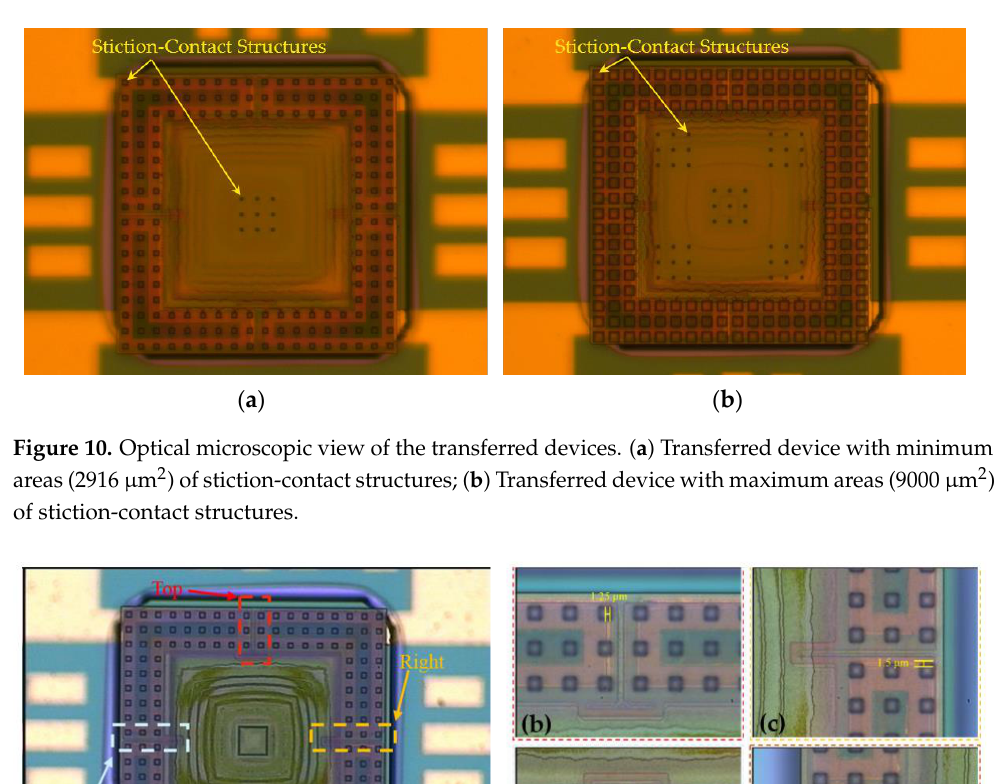
Figure 12. SEM view of the broken area of the temporary support structures of the tactile sensor. ( a ) SEM view of transferred device; ( b – e ) enlarged SEM views of the broken area shown in Figure 13a. As Figures 11a and 12a show, the size of the transferred tactile sensor is 180 μm  180 μm  1.2 μm, and the force area of the tactile sensor is only 120 μm  120 μm  1.2 μm. Moreover, the force application accuracy is extremely high because the designed full-scale force of the designed tactile sensor is only approximately 0.5 mN, and there is no suitable instrument to measure the sensitivity of the transferred tactile sensor directly. Therefore, different masses of the beam-shaped copper wire weights with a diameter of 85 μm are made to measure the sensitivity of the transferred tactile sensor, and the measurement principle of the beam-shaped copper wire weight is shown in Figure 13. As Figure 13 shows, one end of the beam-shaped copper wire weight is placed on the sensitive mem- brane of the transferred tactile sensor, and the other end is placed on the test stage. The force applied to the transferred tactile sensor is half of the mass of the beam-shaped copper wire weight.